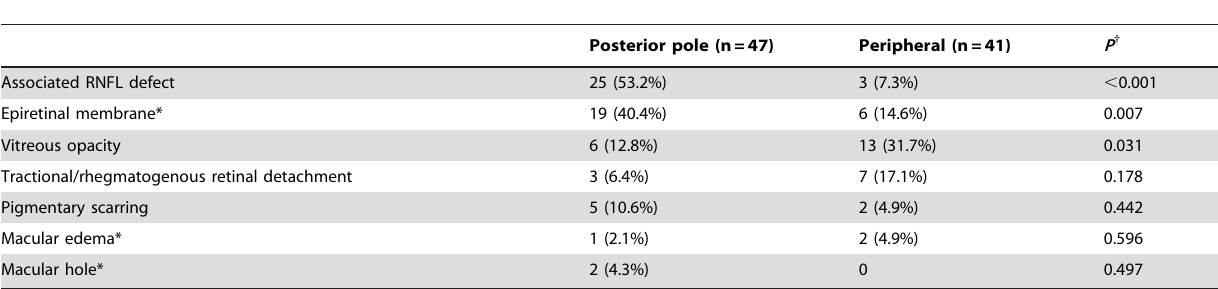
Table 2. Association between granuloma location and comorbidities in eyes with ocular toxocariasis.